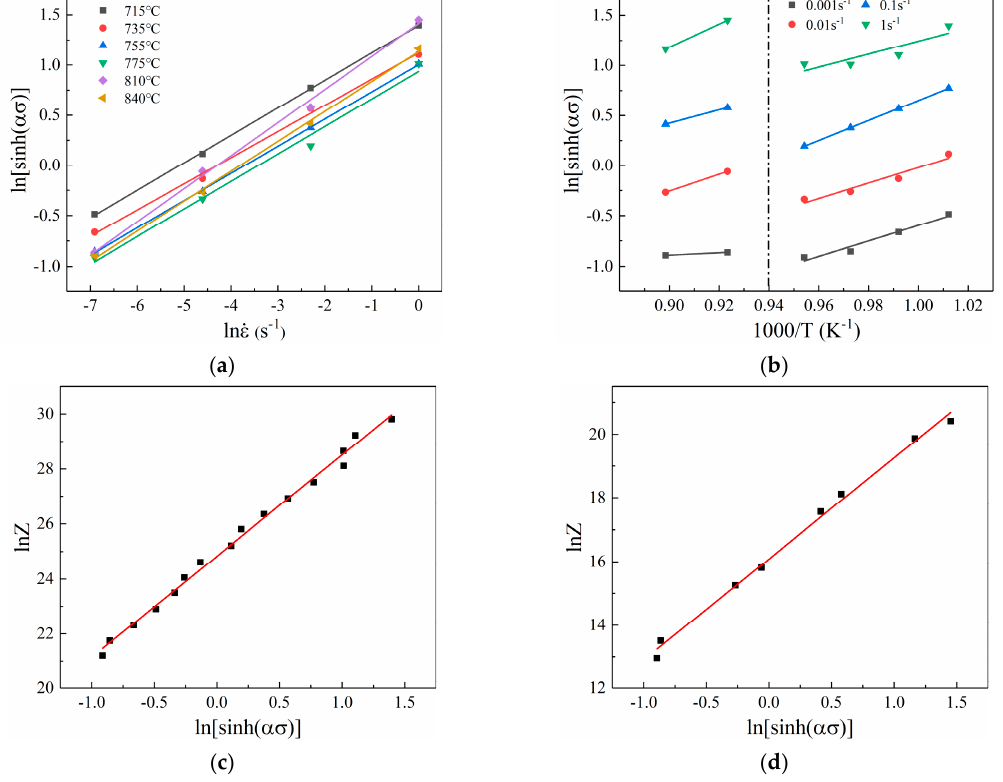
Figure 4. The relationships of ( a ) ln (cid:4670) sinh ( ασ )(cid:4671) and ln ε (cid:4662) ; ( b ) ln(cid:4670)sinh(ασ)(cid:4671)and 1000/T ; ( c ) lnZ and ln(cid:4670)sinh(ασ)(cid:4671) in α + β phase; ( d ) lnZ and ln(cid:4670)sinh(ασ)(cid:4671) in β phase.